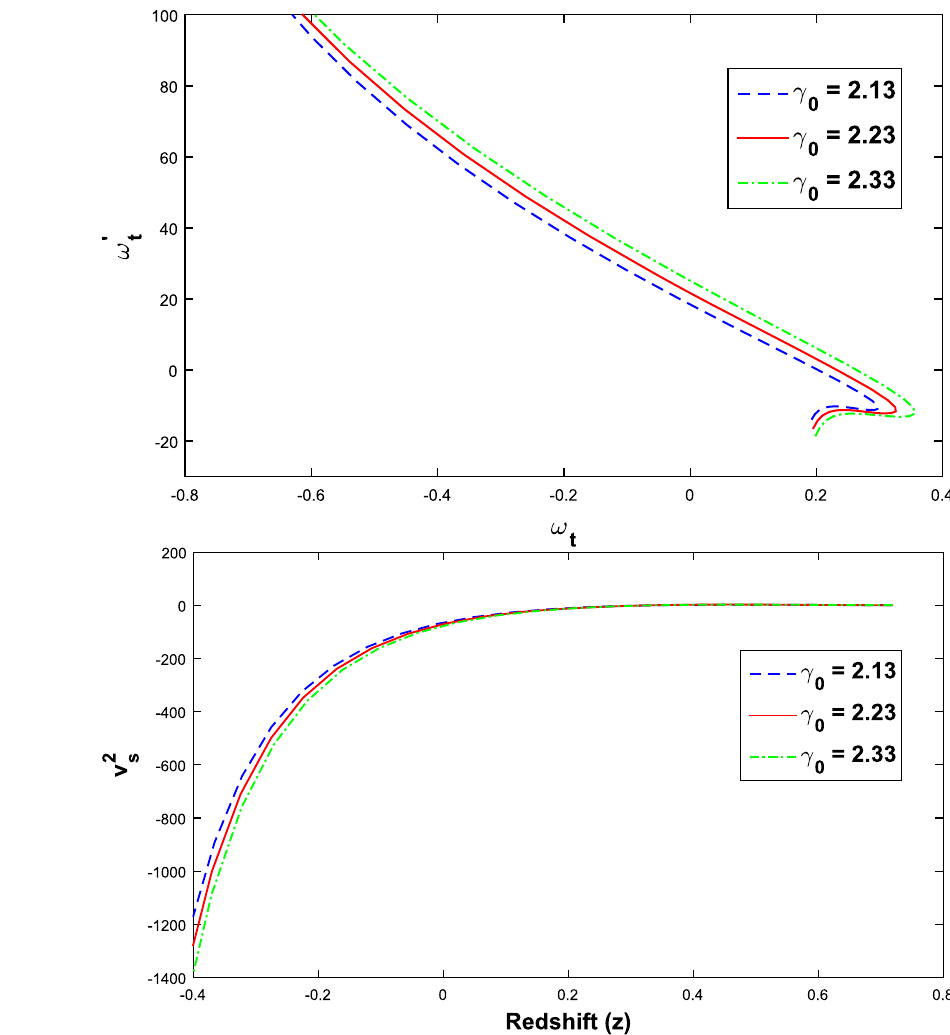
Fig. 5 Plot of ω t versus ω (cid:2) t for c 1 = 0 . 01, c 2 = 0 . 115, k = 0 . 325, γ 0 = 2 . 13, and α = 1 . 5